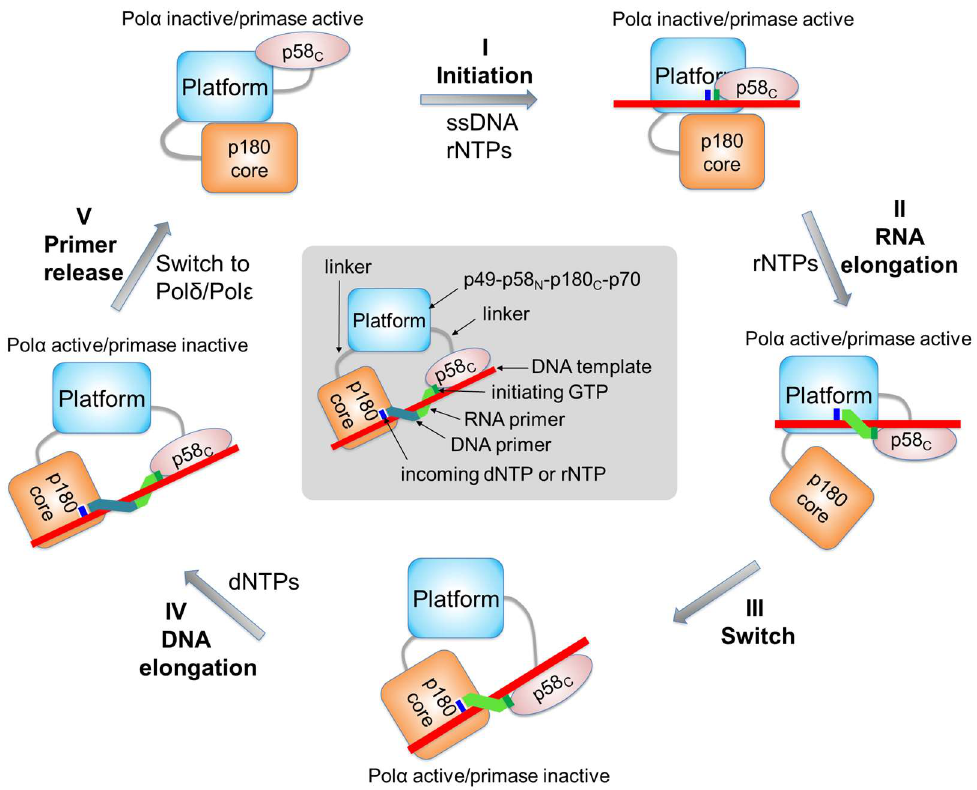
Figure 9. Schematic representation of conformational changes in the primosome during chimeric primer synthesis. At the first step (steps are labeled by roman numerals), p58 C moves toward p49 to initiate RNA synthesis. During the second step, p58 C moves toward p180core and pushes it to dissociate from the platform. Additionally, when RNA primer length is nine nucleotides, p58 C makes a steric hindrance with the platform, which prevents primer extension by p49. At the third step, p58 C rotates and loads the template:primer to the Polα active site. At the fourth step, Polα extends the RNA primer with dNTPs. At the fifth step, the primosome is replaced by Polε or Polδ.